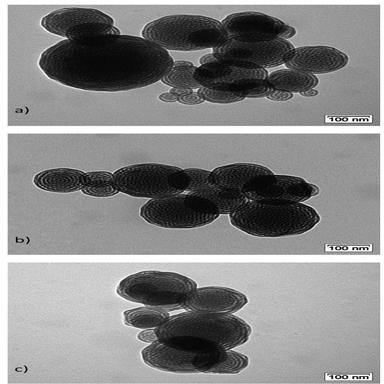
TEM micrographs of Ga-37 (a), Ga-74 (b) and Ga-148 (c) calcined at 550 C.